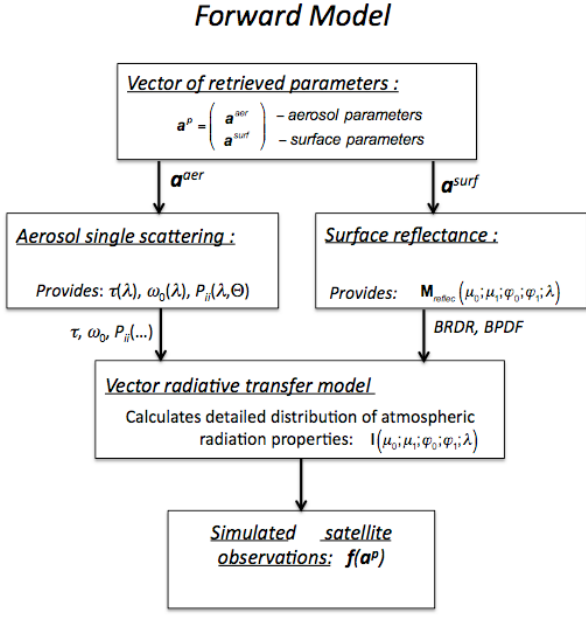
Fig. 3. The organization of the forward calculations of atmospheric radiance measured from a